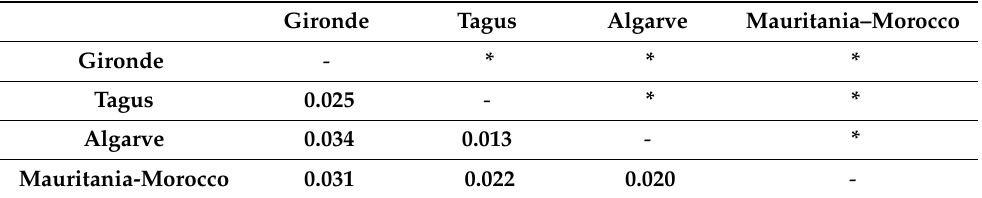
Table 4. Pairwise estimates of F ST values among Argyrosomus regius Atlantic spawning areas (below diagonal) and corresponding p -values (above diagonal; in bold * p < 0.0008 (Bonferroni correction)). For location sites’ acronyms, please check Table